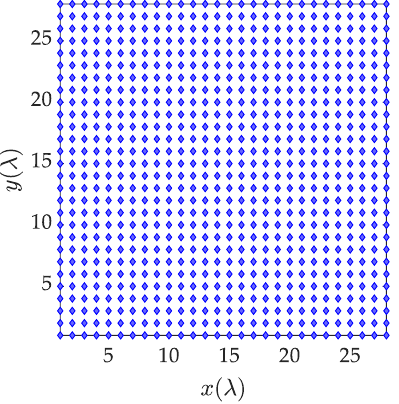
Figure 5. Distribution of array elements before optimization.